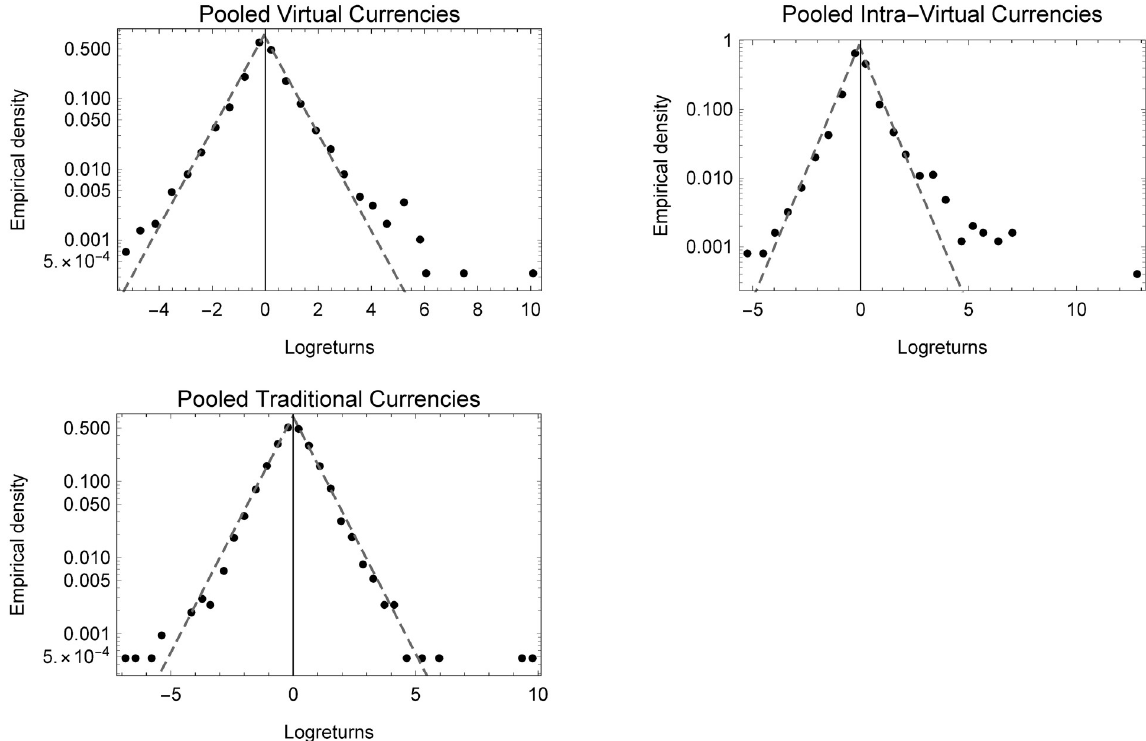
Fig 4. Empirical densities of standardized and pooled currencies. Empirical densities of standardized and pooled currency log-returns for all three groups of virtual, intra-virtual and foreign currency exchange rates.